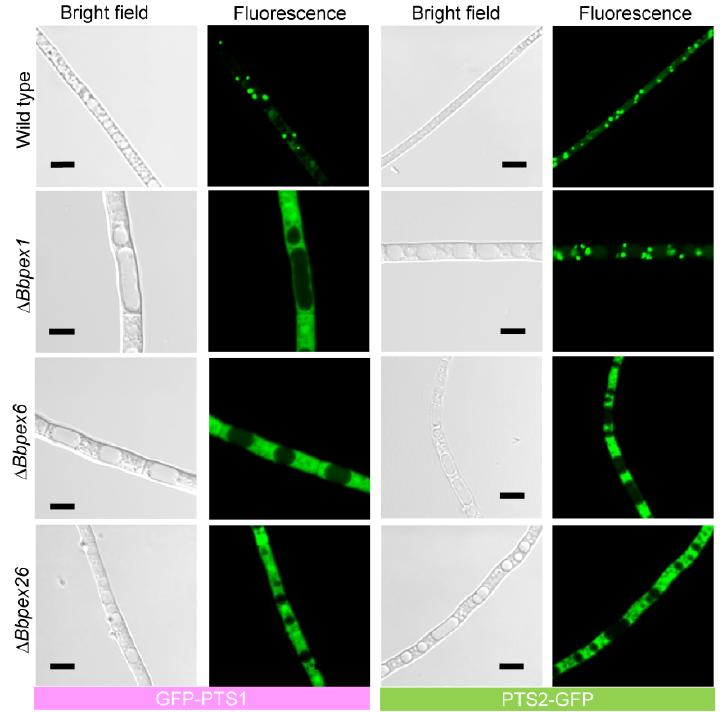
Figure 2. Translocation processes of peroxisomal proteins. Peroxisomal targeting signal (PTS) type 1 and type 2 were fused to the green fluorescent protein gene (GFP). The fusion gene was introduced into the wild-type and Δ Bbpex1 , Δ Bbpex6 , and Δ Bbpex26 mutant strains. Granular signals were obviously observed in the wild-type strain. Signals from GFP-PTS1 were evenly distributed in the cytoplasm. As for PTS2-GFP, granular signals were only observed in the Δ Bbpex1 strain. Scale bar: 5 µm.